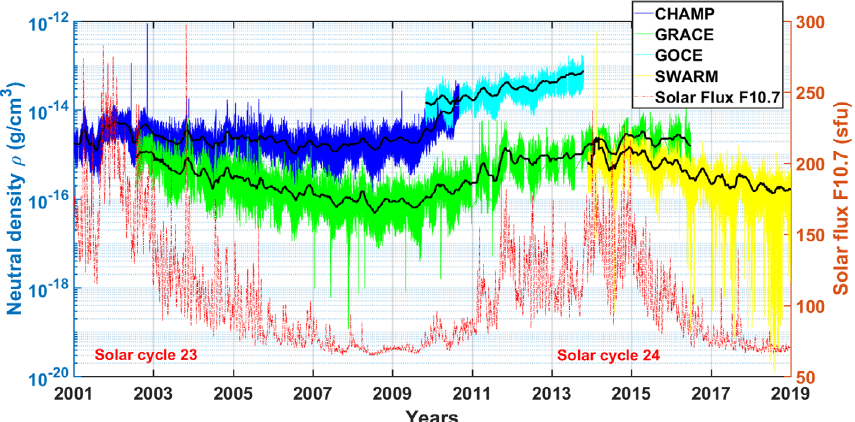
Fig. 1. Neutral density derived from CHAMP, GRACE, GOCE, and SWARM satellites (2001 – 2019). Neutral density is in the log scale with the monthly-averaged neutral density in black color. Solar Flux F10.7 is